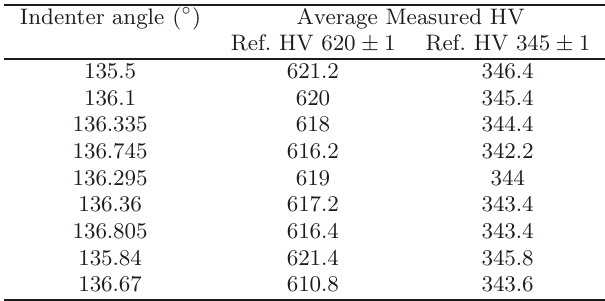
Table 2. Effect of indenter angles for HV measurement in 2 different reference HV blocks.